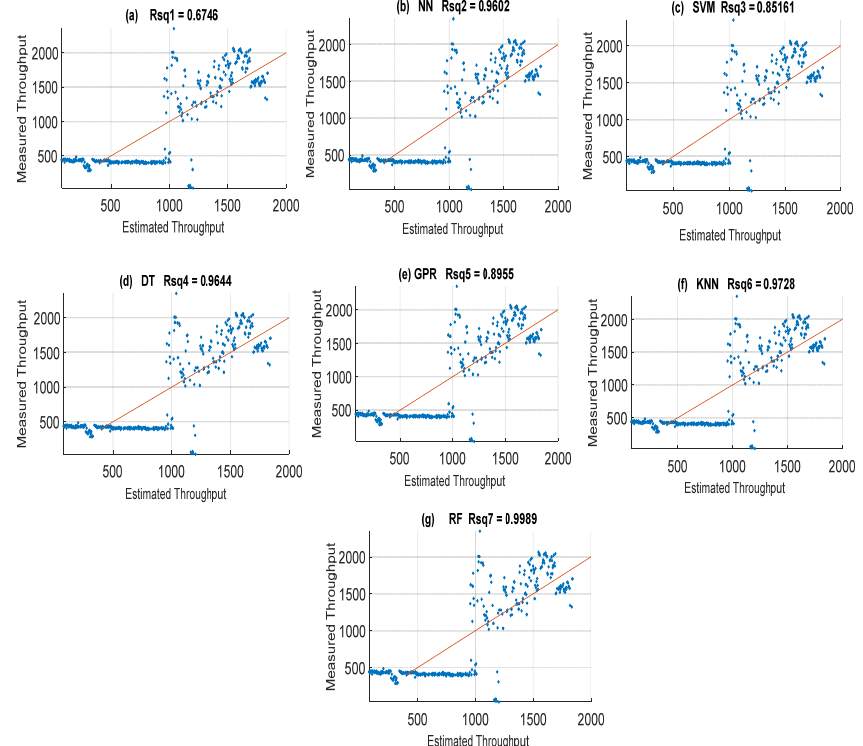
Figure 5. Throughput quality prediction accuracy with Rsq attained by the different machine learning models on throughput quality. ( a ) Least-squares (LS). ( b ) Neural networks (NNs). ( c ) Support vector machine (SVM). ( d ) Decision tree (DT). ( e ) Gaussian process regression (GPR). ( f ) K-nearest neighbor (KNN). ( g ) Random forest